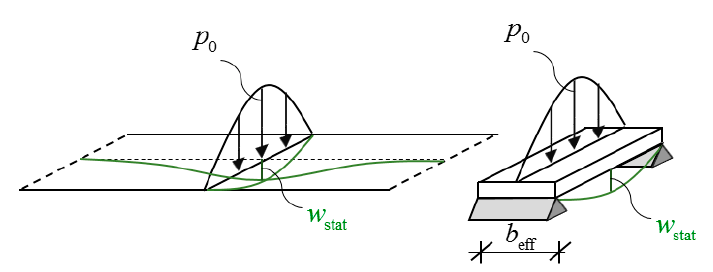
Figure 5. Methodology to determine the effective width.